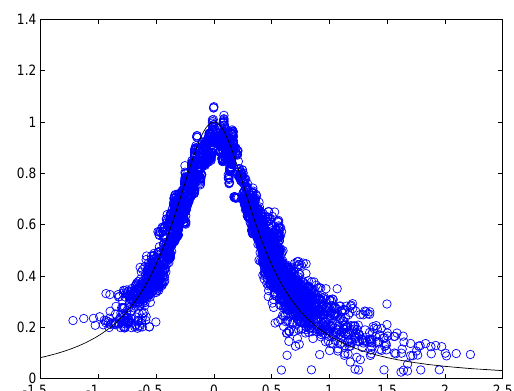
Fig. 5. Phase plane β Z ( t ) as a function of Z ( t ) for the process of Figure 4 and theoretical self-regulating function. The blue circles are the points ( Z ( t ) ,β ( t )) and the solid black line is the theoretical g function.